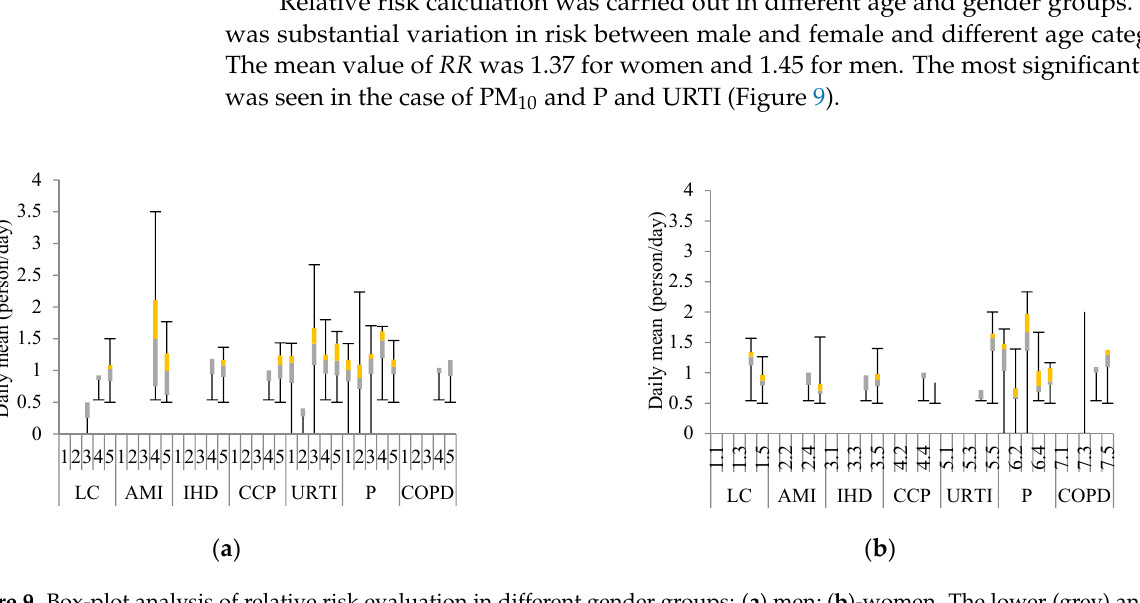
Figure 9. Box-plot analysis of relative risk evaluation in different gender groups: ( a ) men; ( b )-women. The lower (grey) and upper (yellow) limits represent the first (25P) and third (75P) quartiles, and the ends of the whiskers represent the minimum and the maximum values.